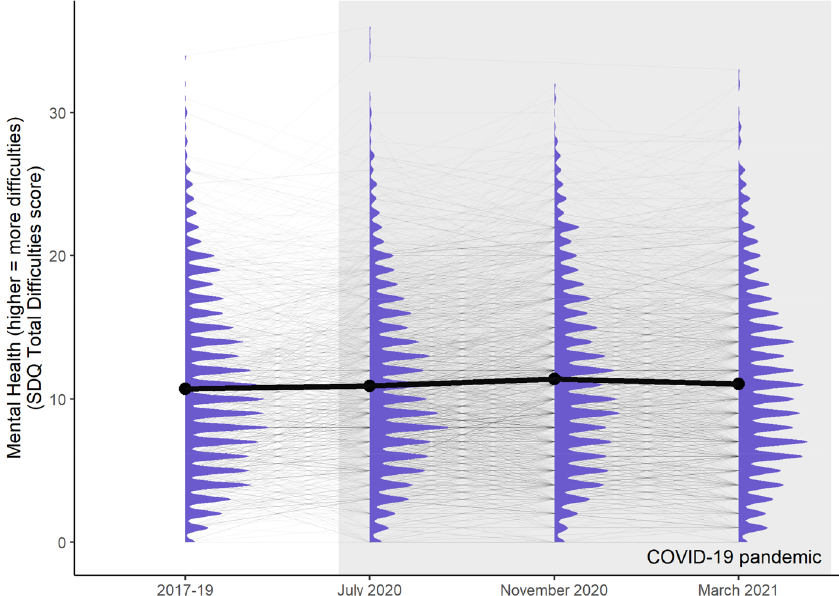
Figure 1. Adolescent SDQ Total Difficulties scores, 2017 to March 2021. For each wave, we plotted the distribution of mental health scores (blue violin plots). The mean of each wave (black) is included to highlight the change in average scores between waves, and individual raw scores are also displayed (grey). The timing of the COVID-19 pandemic is indicated in